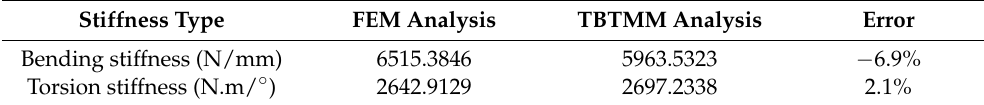
Table 1. Material property of tread